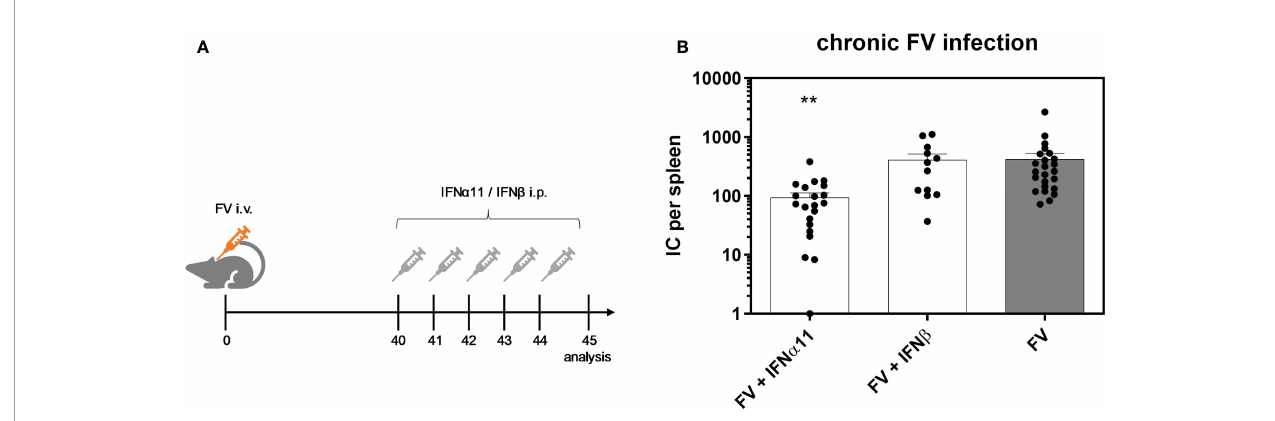
FIGURE 2 | Antiretroviral activity of IFN a 11 and IFN b during chronic FV infection. (A) The scheme of the experimental timeline is shown. C57BL/6 mice were infected with 20,000 SFFU of FV and additional 100,000 FFU of F-MuLV. Mice were treated daily with 8000 units of IFN a 11 or IFN b from day 40 to 44 mice. At day 45 post infection, mice were sacri fi ced and viral loads were analyzed by an infectious center assay (B) . 24 mice per FV-infected group, 21 mice per IFN a 11-treated group and 12 mice per IFN b -treated group were analyzed and the mean values for each group are indicated by a bar (+SEM). Data were pooled from four independent experiments with similar results. Statistically signi fi cant differences between the control group (FV) and the groups of IFN-treated mice (FV + IFN a 11 or FV + IFN b ) were tested using Kruskal-Wallis one-way and Dunn ’ s multiple comparison and are indicated by ** for p <